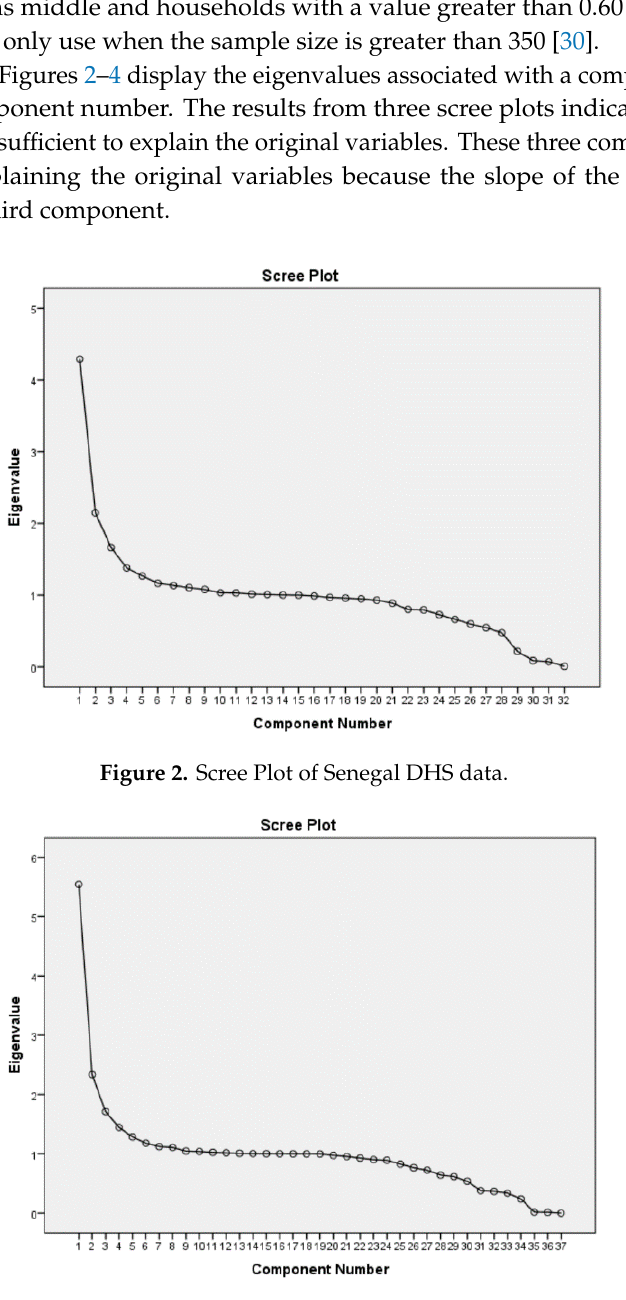
Figure 3. Scree Plot of Malawi DHS data.